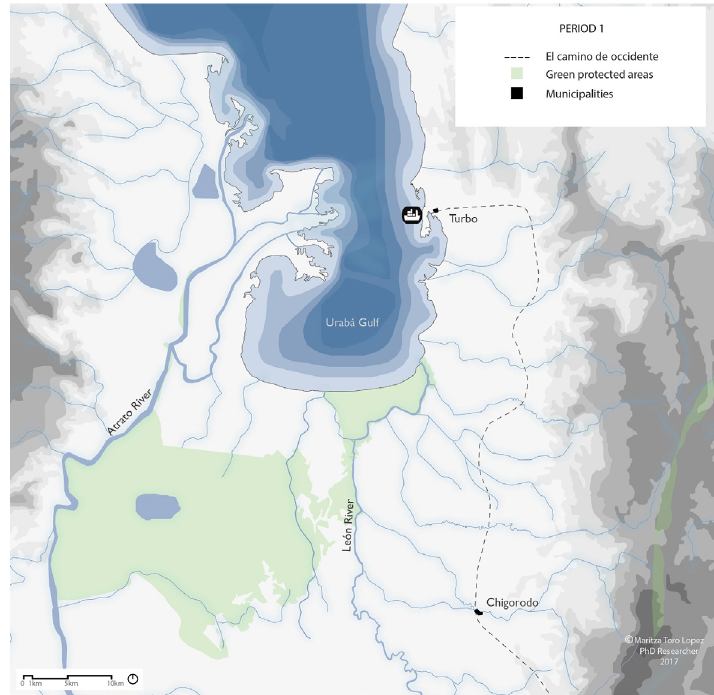
Fig. 2. Period 1 : El camino de occidente , the first infrastructure that supported extractivism. Source: own